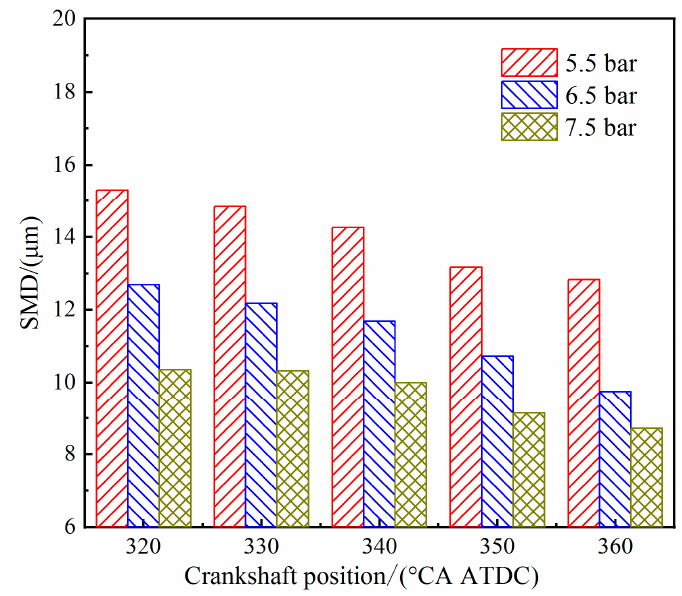
Figure 11. Atomization size of fuel droplets in-cylinder at different injection